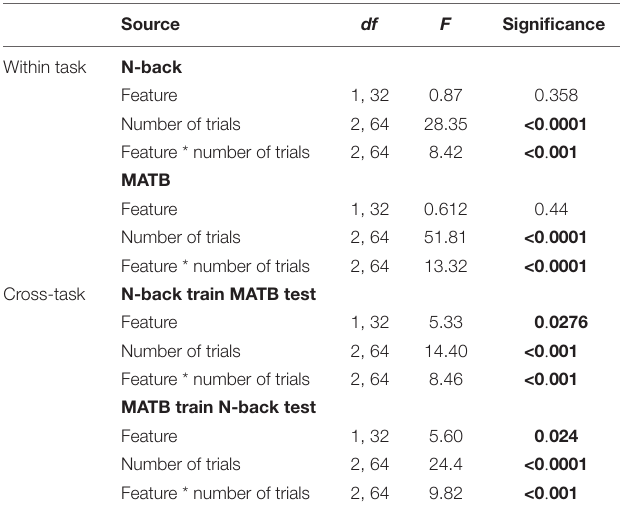
TABLE 3 | Two-way repeated-measure ANOVA results of within-task and cross-task classification results. Source df